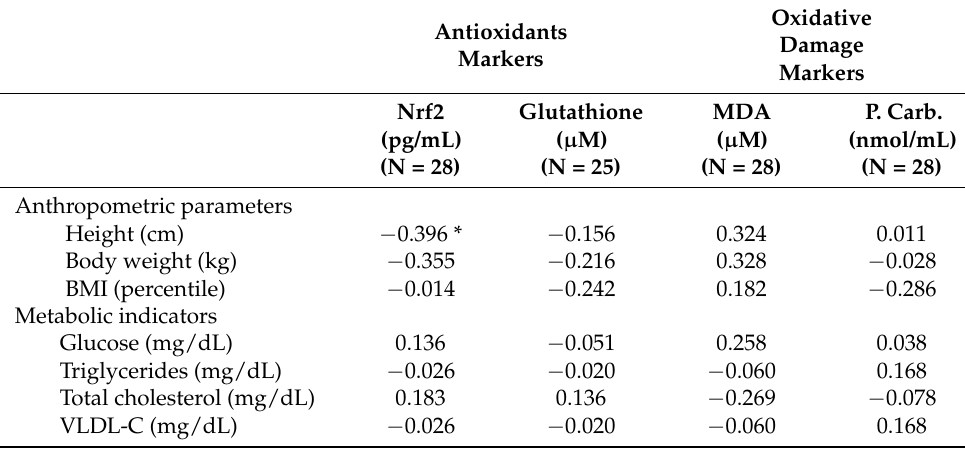
Table 2. Correlation of circulating markers of OS with anthropometric parameters, metabolic indica- tors, physical activity parameters, and frequency of AFC of DMD